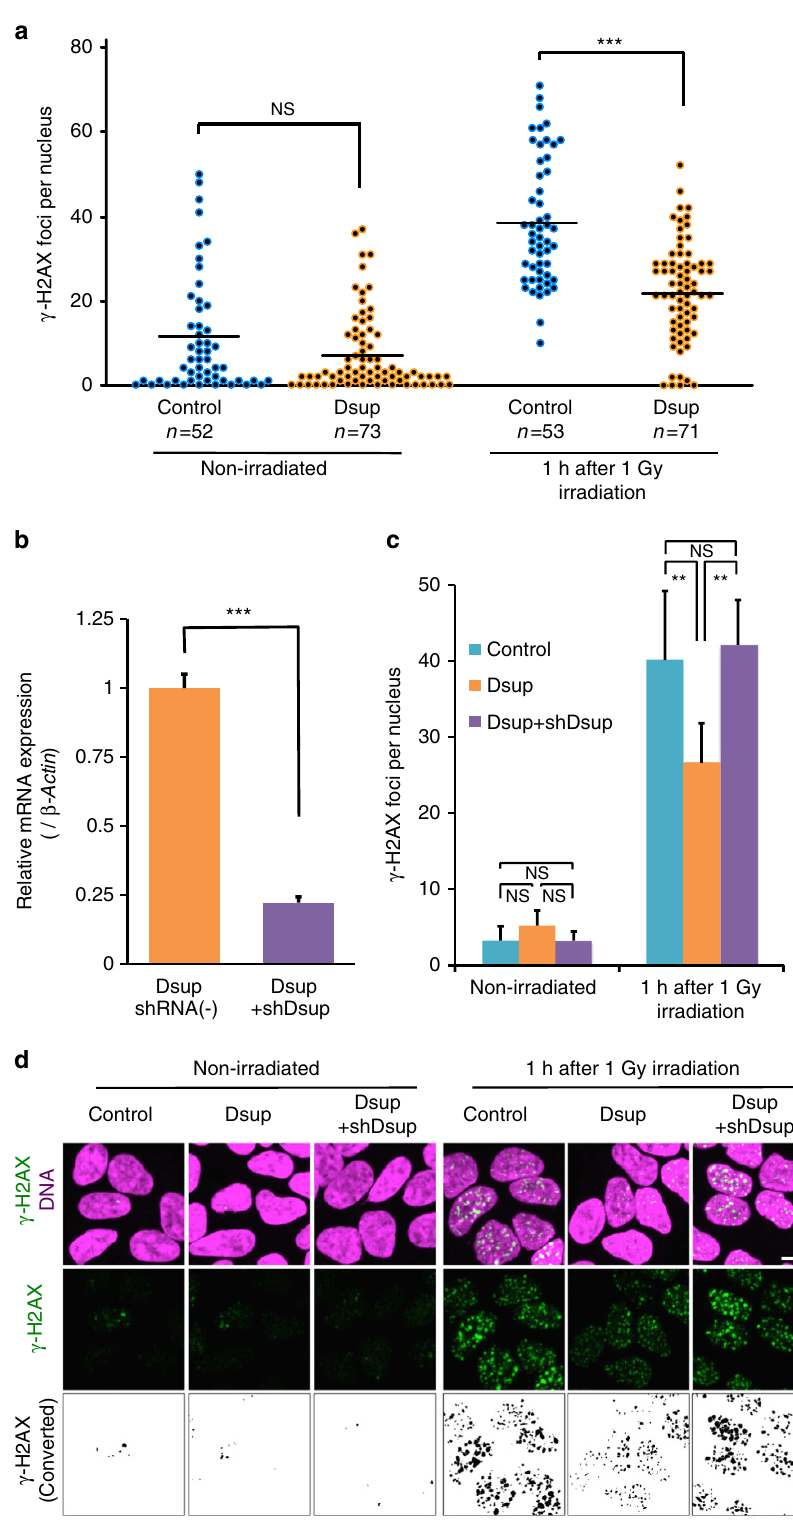
Figure 5 | Reduced formation of c -H2AX foci in human cultured cells depending on Dsup expression. ( a ) Distribution of the numbers of g -H2AX foci per nucleus is shown. Each dot represents an individual nucleus of a HEK293 cell (Control) or a Dsup-expressing cell (Dsup) under non-irradiated and irradiated conditions. *** P o 0.001; NS, not significant (Welch’s t -test). ( b ) Significant decrease of Dsup transcript in shRNA-introduced cells (Dsup þ shDsup) compared with that in untreated Dsup-expressing cells (Dsup shRNA( (cid:2) )). n ¼ 3. Values represent mean ± s.e.m. *** P o 0.001 (Student’s t -test). ( c ) Quantitative comparison of g -H2AX foci number among untransfected HEK293 cells (Control), Dsup-expressing cells (Dsup) and Dsup-knockdown cells (Dsup þ shDsup) under non-irradiated and 1Gy X-ray irradiated conditions. At least 70 cells were analysed for each condition. Values represent mean ± s.d. ** P o 0.01; NS indicates not significant (Tukey–Kramer’s test). ( d ) Representative images detecting g -H2AX foci in each condition. Fluorescent images were converted to binary images for automatic counting of foci. Scale bar, 10 m